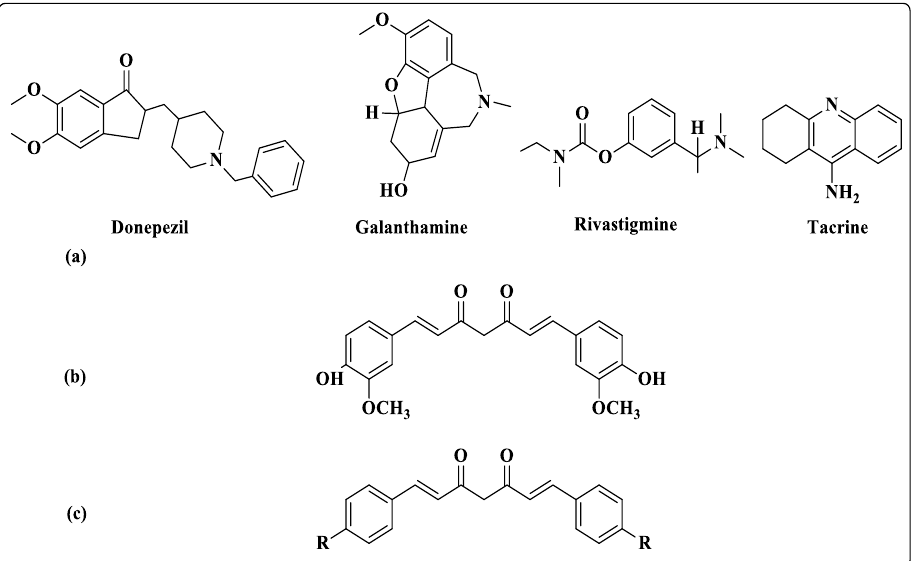
Figure 1. ( a ) Cholinesterase inhibitors ( b ) Chemical structure of natural curcumin ( c ) General structure of curcumin analogs.